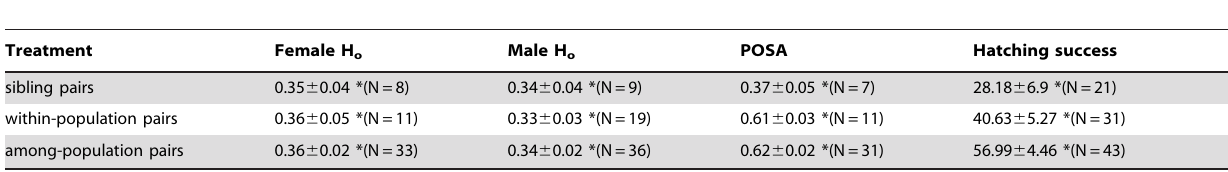
Table 1. Summarised results of the three mating treatments in A. bruennichi including averaged observed Heterozygosity (Ho) per female and male, averaged proportion of shared alleles (POSA) and averaged hatching success per mating pairs.